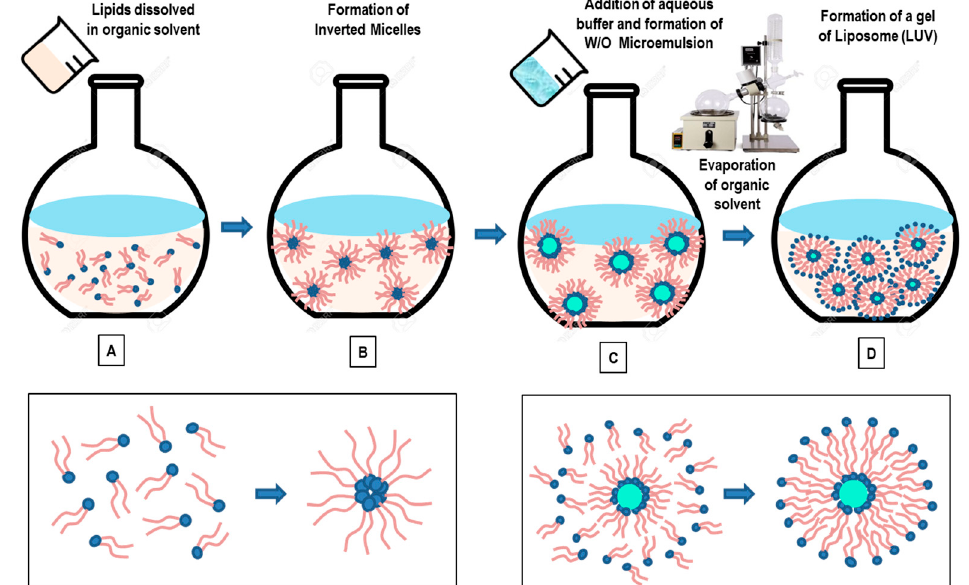
Figure 6. Schematic representation of the main stages of the reverse-phase evaporation method. Lipids are dissolved in organic solvent ( A ), and the formation of inverted micelles is observed ( B ). The addition of aqueous media (buffer), followed by emulsification of the solution, favors the formation a homogeneous dispersion of a W/O microemulsion ( C ). With the final elimination of the organic solvent (by using rotary evaporation, under vacuum), a viscous gel is formed in the solution, which finally collapses to form liposomes ( D )